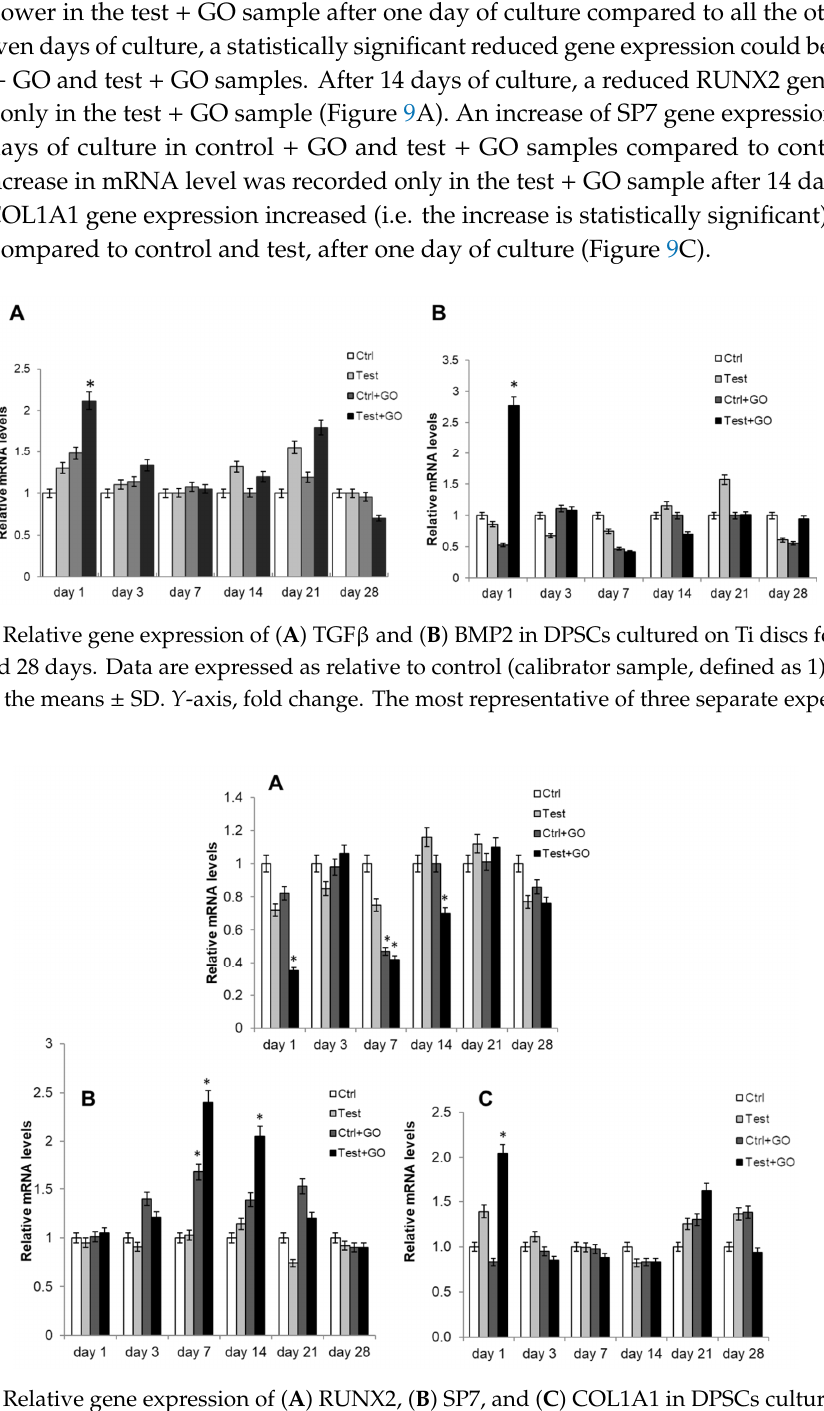
Figure 7. LDH assay of DPSCs cultured on control, test, control + GO, and test + GO discs for 3, 7, 14, 21, and 28 days. LDH released is reported as percentage. Data shown are the mean (± SD) of three separate experiments.